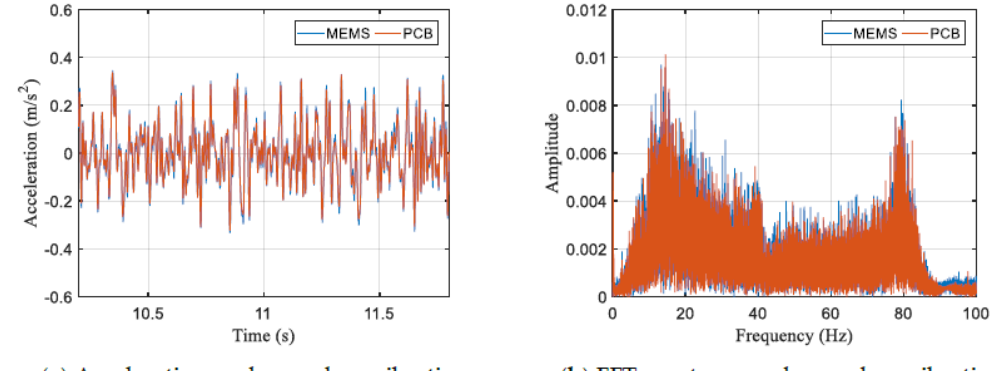
Figure 14. Measured acceleration time histories and FFT spectra by the MEMS and PCB accelerometers under random excitation.